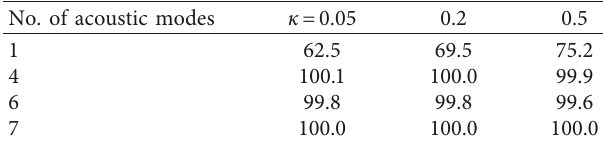
Table 2: (2,1) mode peak vibration amplitude convergence for various excitation magnitudes (3 antisymmetric structural modes, ζ � 0.02).